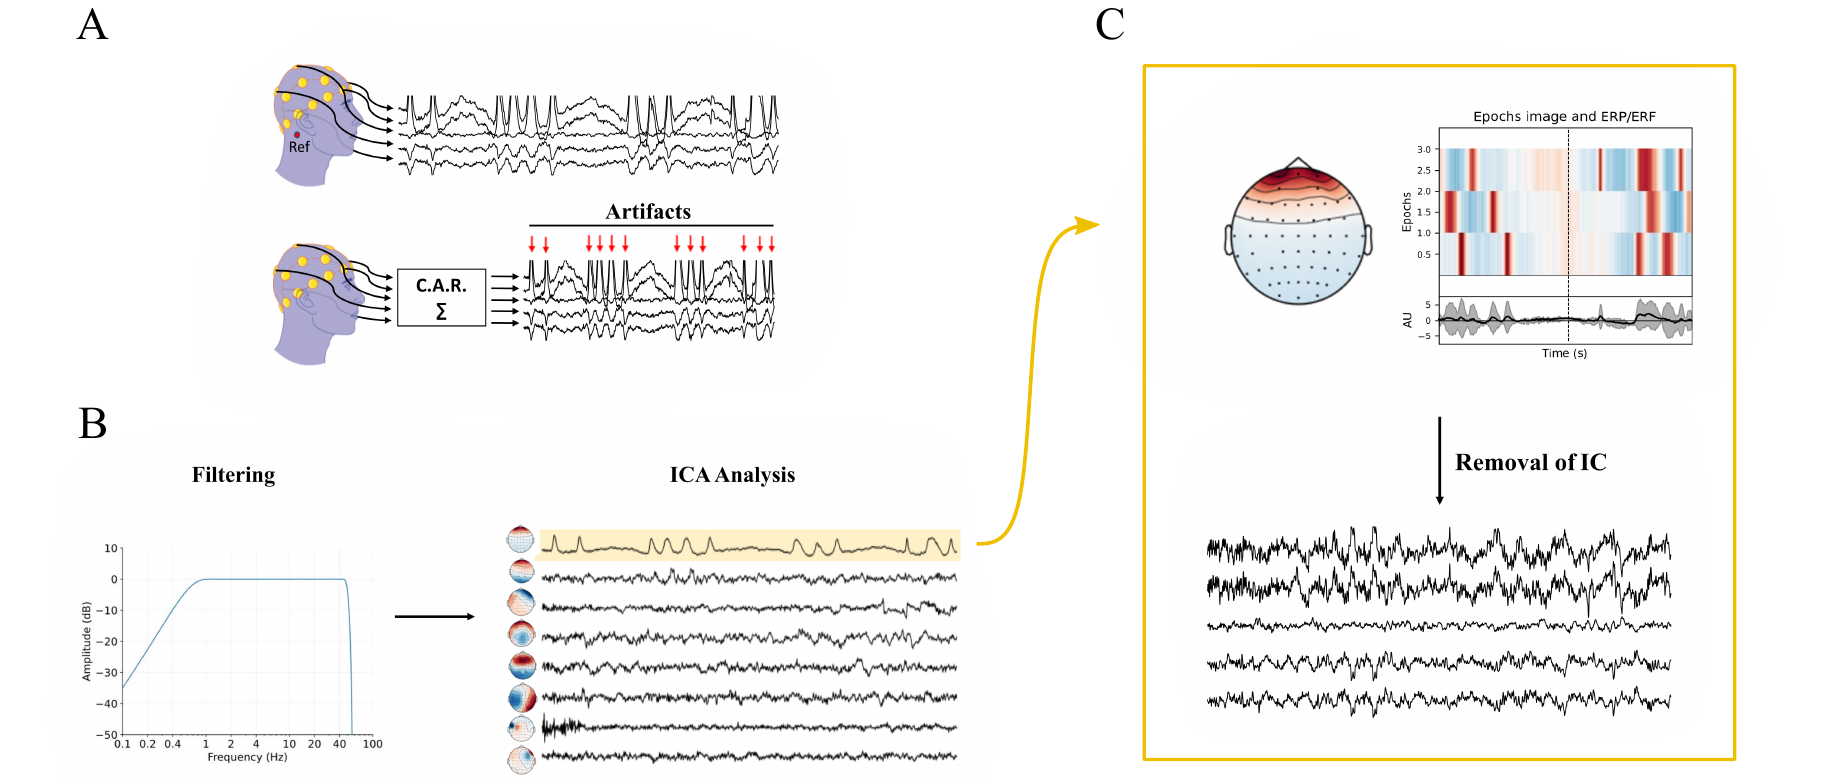
Figure 4. Schematic representation of the pre-processing pipeline applied to EEG signals acquired on the scalp (s253 recording of the subject 2 that could be found in https://eeglab.org/tutorials/10_Group_analysis/study_creation.html#description-of-the-5-subject-experiment-tutorial-data). ( A ) Unipolar EEG signals are acquired using a mastoid reference (Ref, in red). For clarity, only a limited number of the recorded signals, among the original 30 channels, is plotted. The average re-referencing process and the pre-processed signals are illustrated below. Notably, red arrows indicate blinking artifacts that are clearly visible. ( B ) The re-referenced signals are filtered using a 1–45 Hz zero-phase pass-band filter, followed by independent component analysis (ICA) to extract eight independent components (ICs), shown on the right. ( C ) The first IC, suspected to be an artifact, is analyzed, with a scalp-shaped heatmap assessing its localization in the frontal area and its temporary coincidence with the artifacts shown in panel ( A ). After removing the first IC, the cleaned signal is plotted at the bottom of the